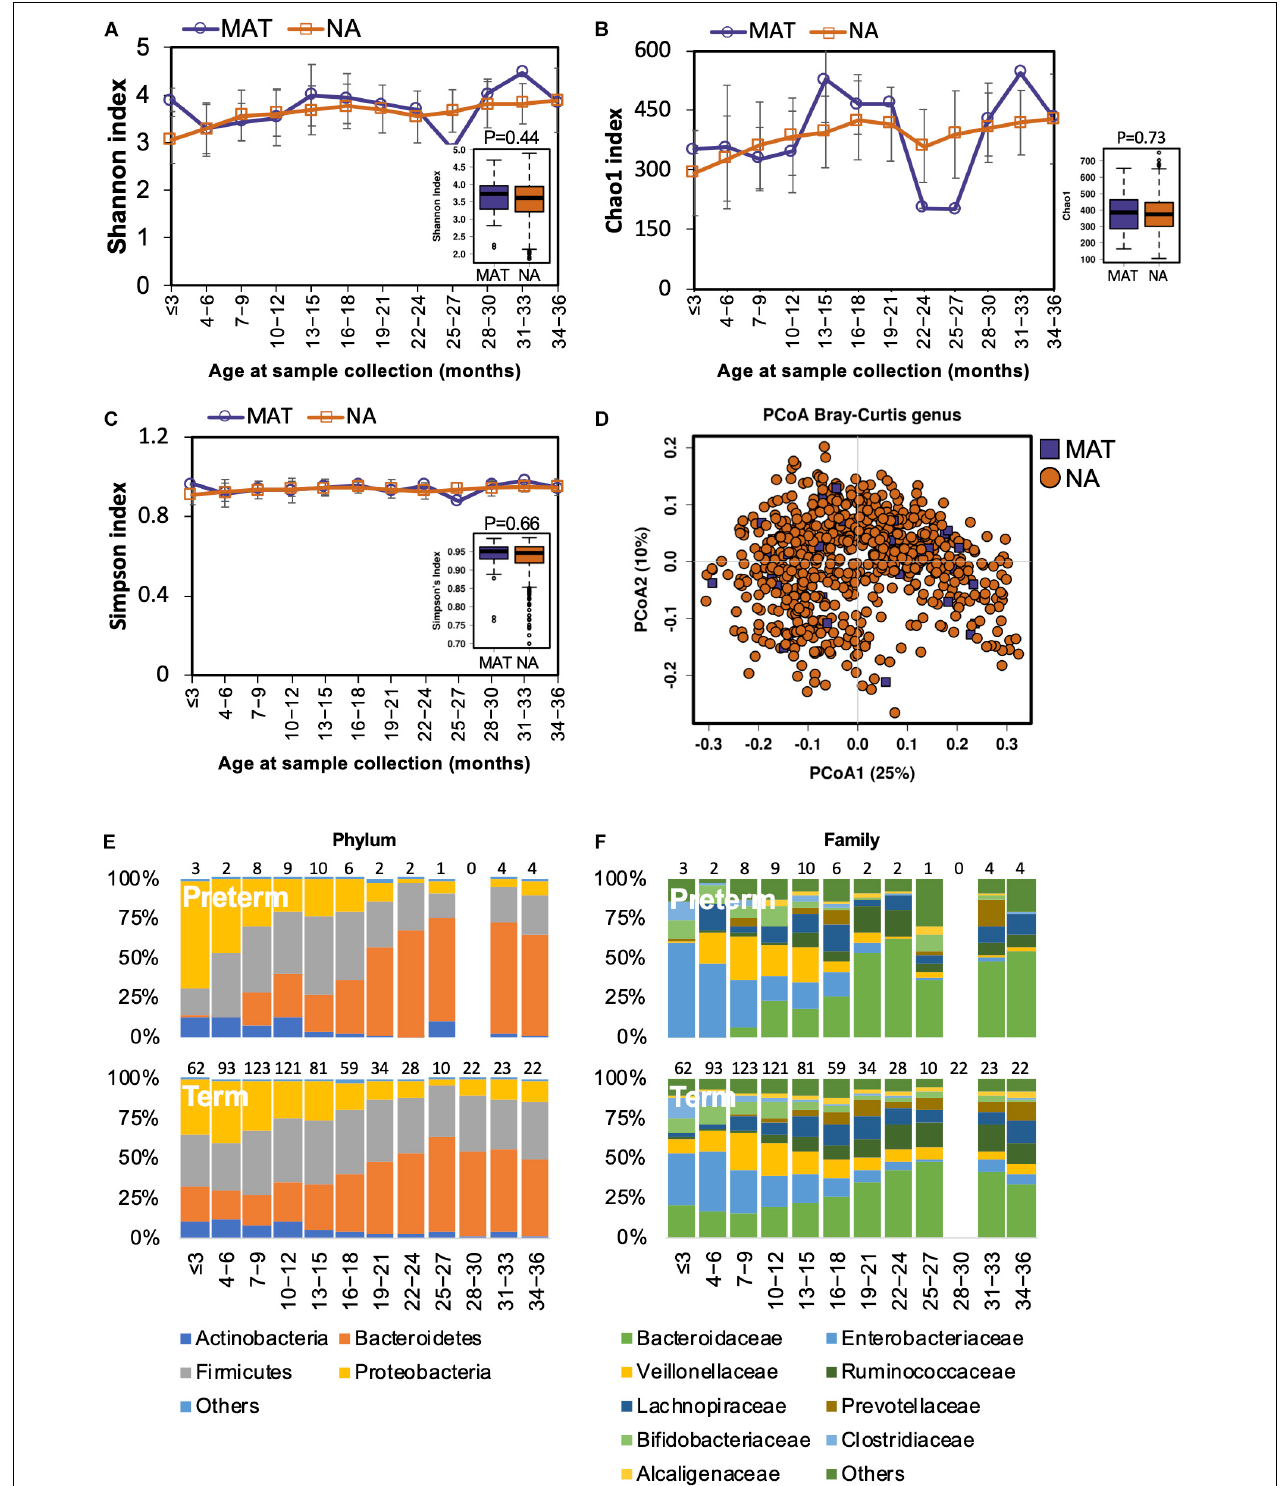
FIGURE 4 | Fecal microbiota diversity and composition for 729 children according to maternal antibiotic exposure. Alpha diversity, which was calculated with (A) Shannon index, (B) Chao1, and (C) Simpson’s index, showed no significant difference between MAT and NA children. (D) PCoA showed no clear separation between samples from MAT and NA children. The gut microbiota development patterns in MAT and NA children at the (E) phylum and (F) family levels. Number of children per age group is provided above bars.